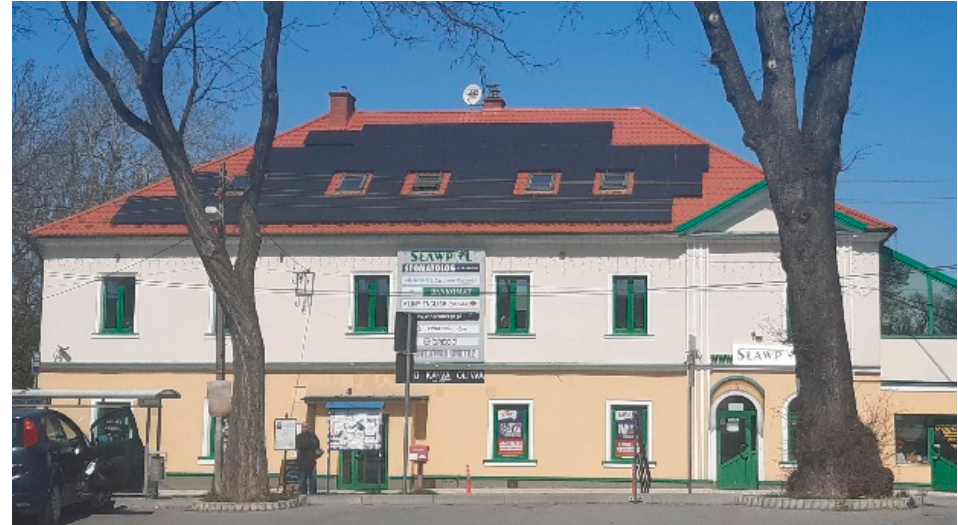
Figure 13. Disharmonious color composition on the building’s roof covered with red ceramic tiles and monocrystalline PV panels (photo by W. Celadyn).